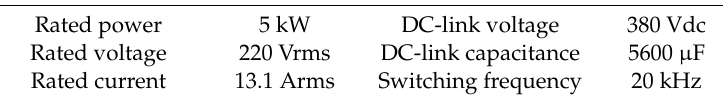
Table 3. Specifications of the PMSG